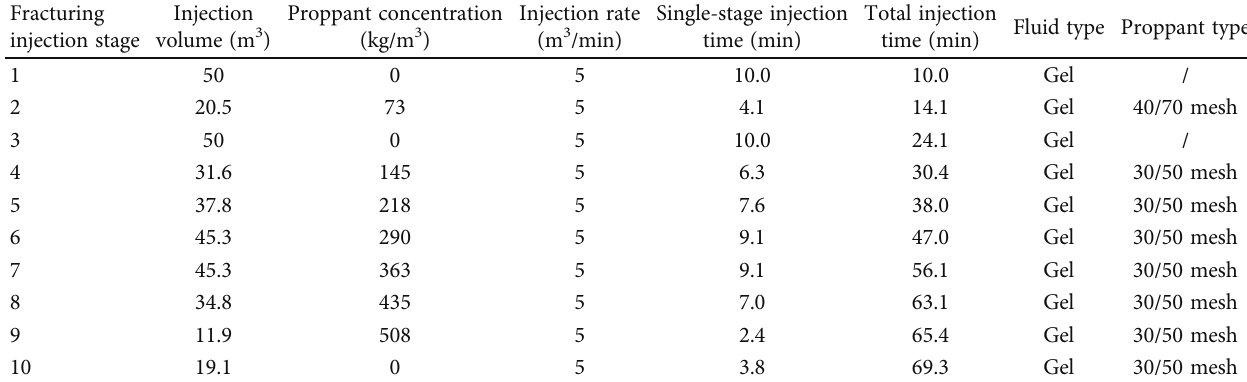
Table 5: The injection pumping procedure for hydraulic fracturing of well